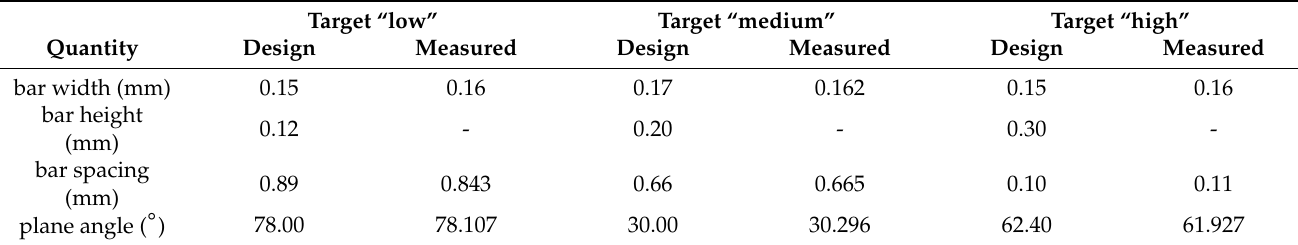
Table 8. Design parameters and measured values of the specimens designs using the ANN model. The printed specimens are measured using 3D surface profilometer, quantities marked with a dash (‘-’) could not be measured due to the measurement principle. Target “low” Target “medium” Target